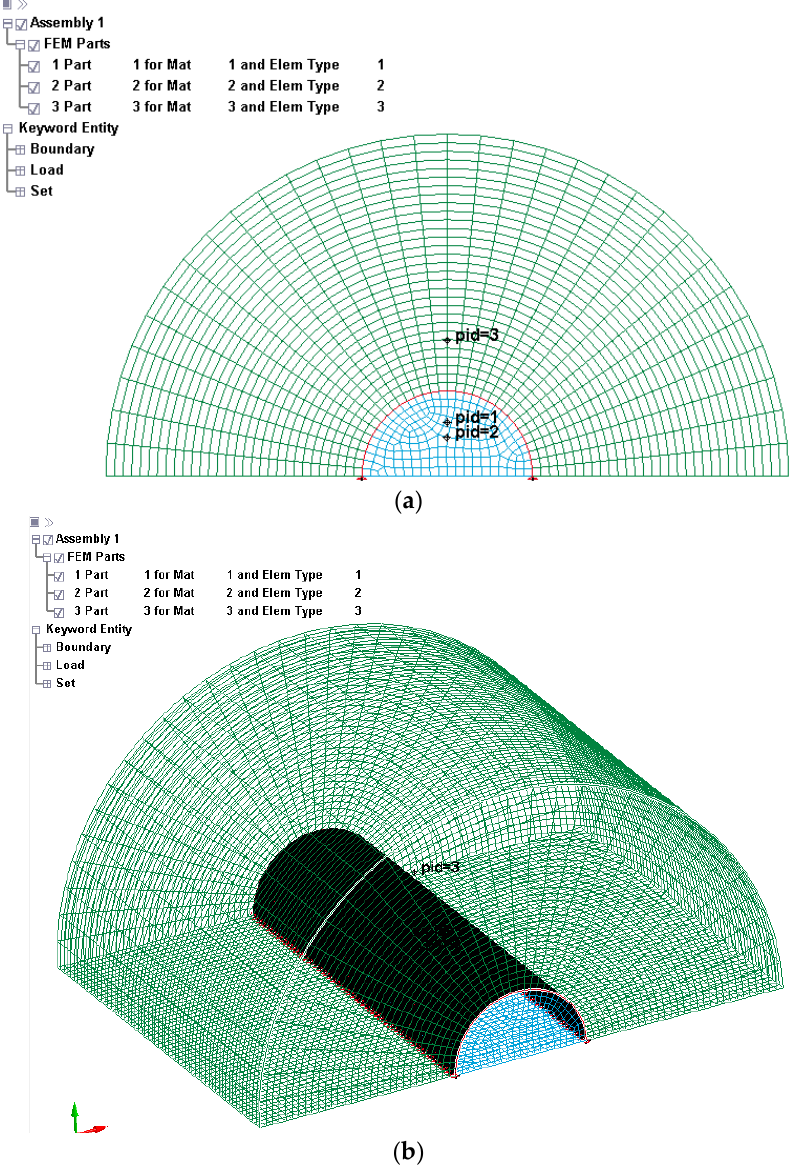
Figure 7. The sketch of the finite element model. ( a ) The mesh in the Z=0 plane, ( b ) The mesh of 3-D